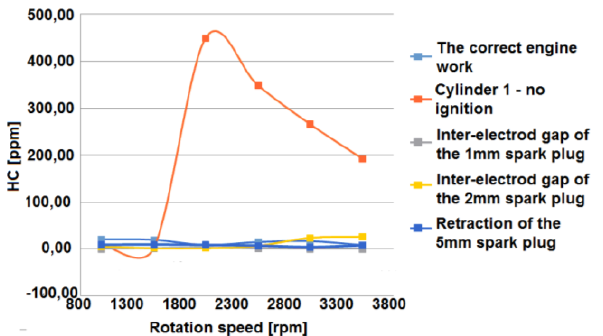
Fig. 21. The value of the Fiat 1.1 engine's excess air